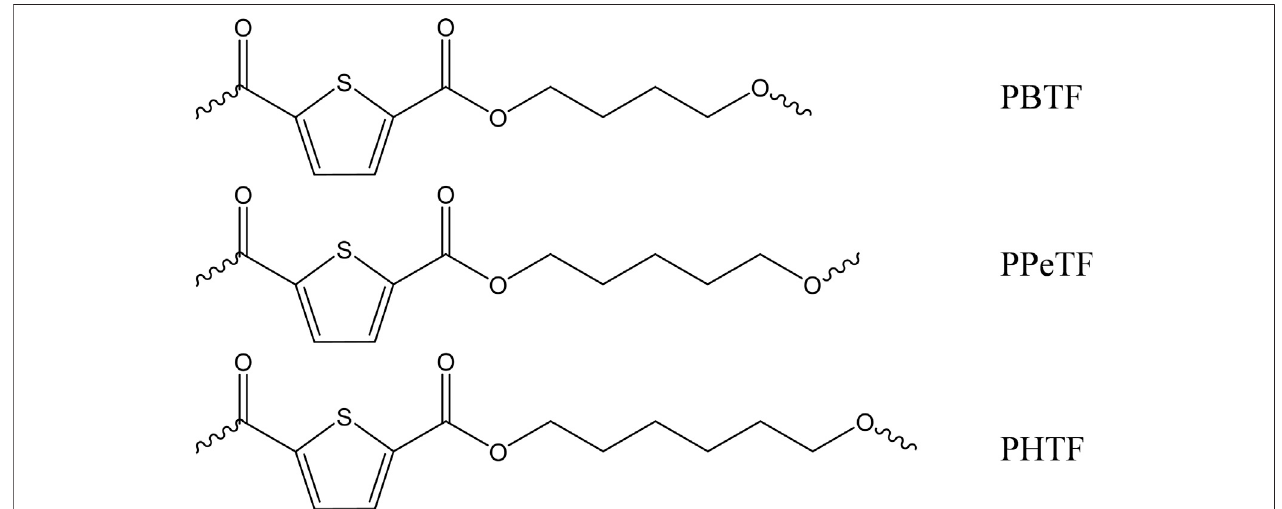
FIGURE 1 | Chemical structure of PBTF, PPeTF, and